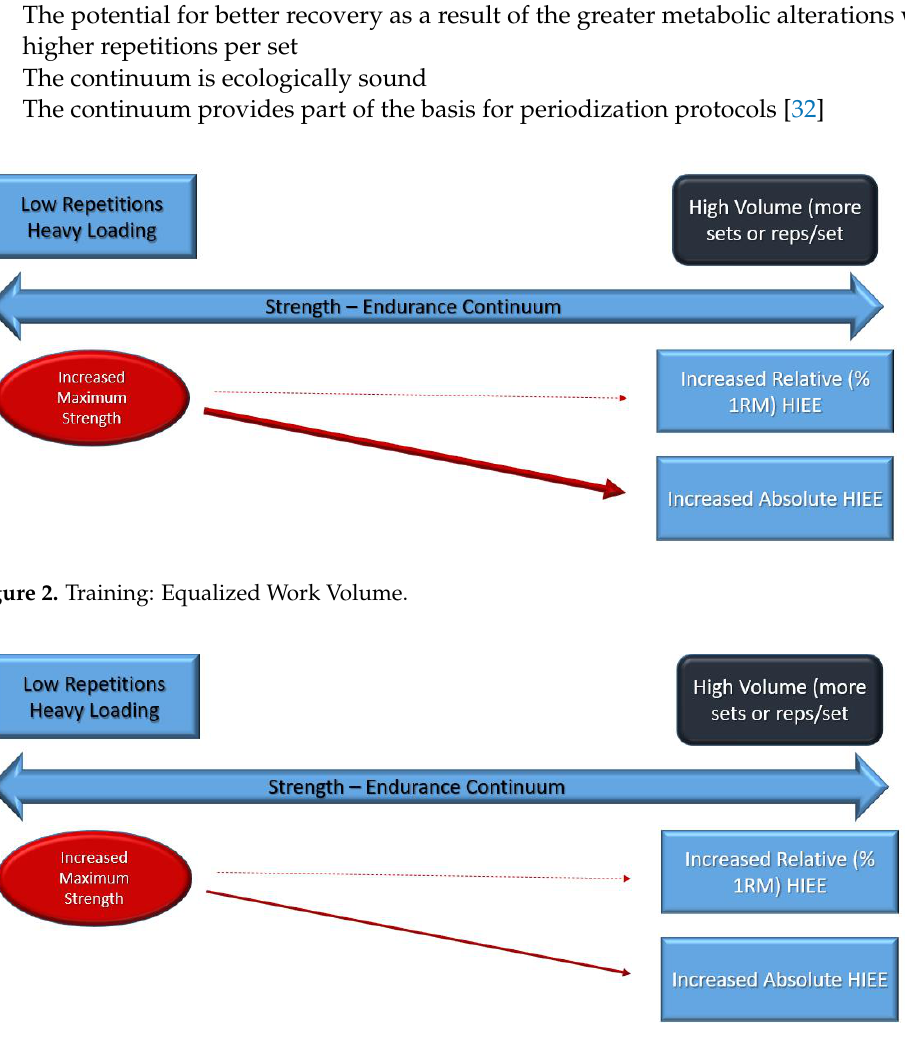
Figure 3. Training: Non-Equalized Work Volume.